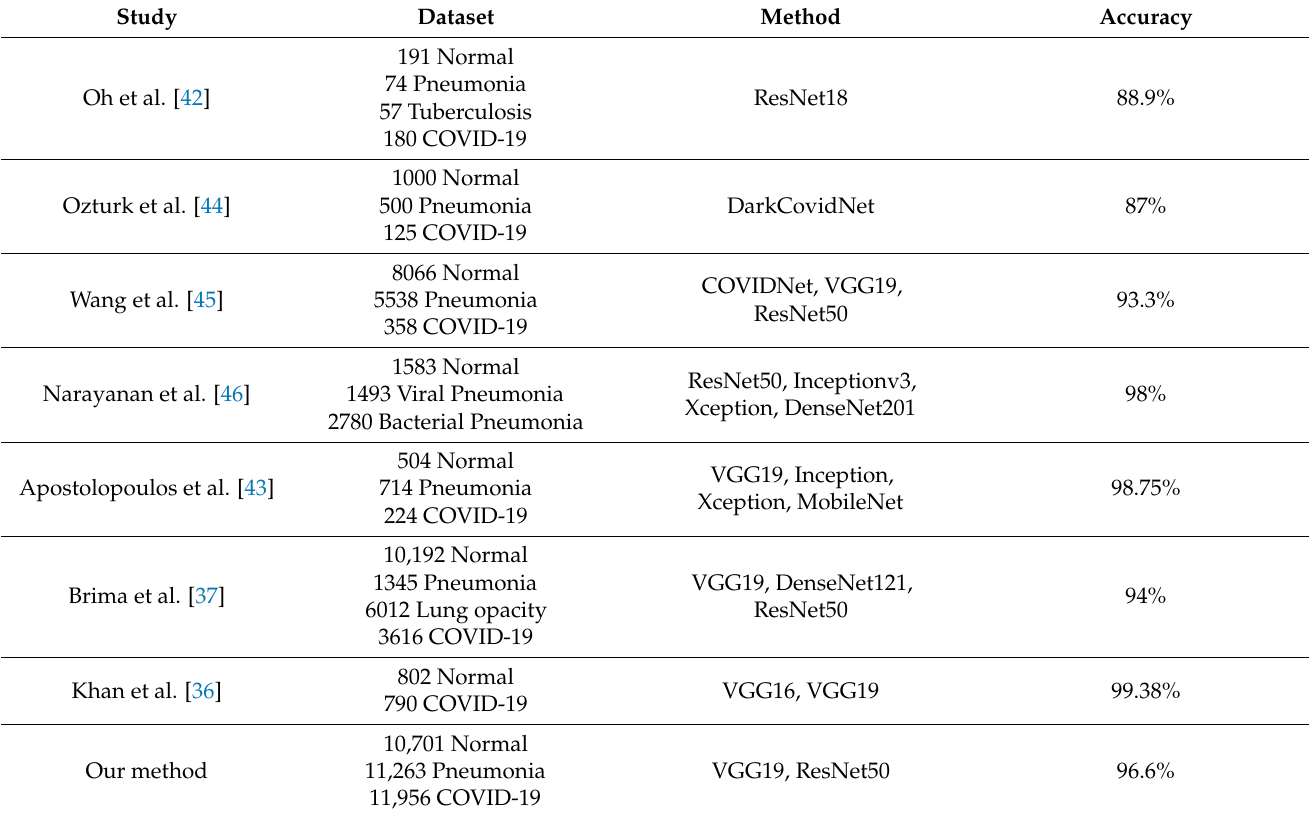
Table 2. Comparison of the proposed methodology with the related